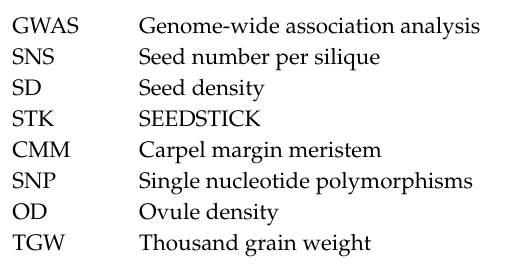
Figure S1: Gene Expression Patterns of PIN3 . Table S1: List of Arabidopsis accessions used in the study and their seed number data. Table S2: Details of potential candidate gene functions harboring SNPs a ff ecting seed number per silique in Arabidopsis . Table S3: Primer sequences used in this